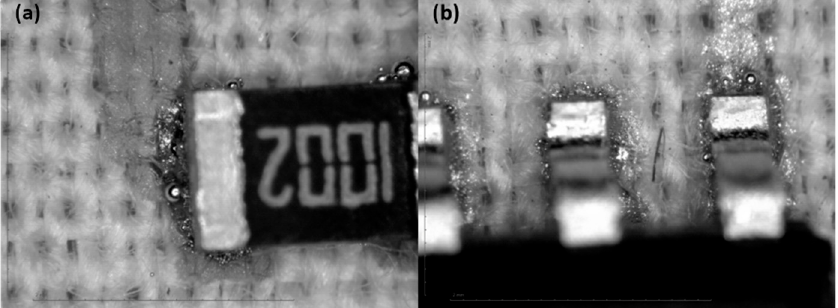
Figure 12. Soldering microscope pictures of 0805 ( a ) and SOIC8 ( b ) packages with solder paste Chipquick TS3911T50.